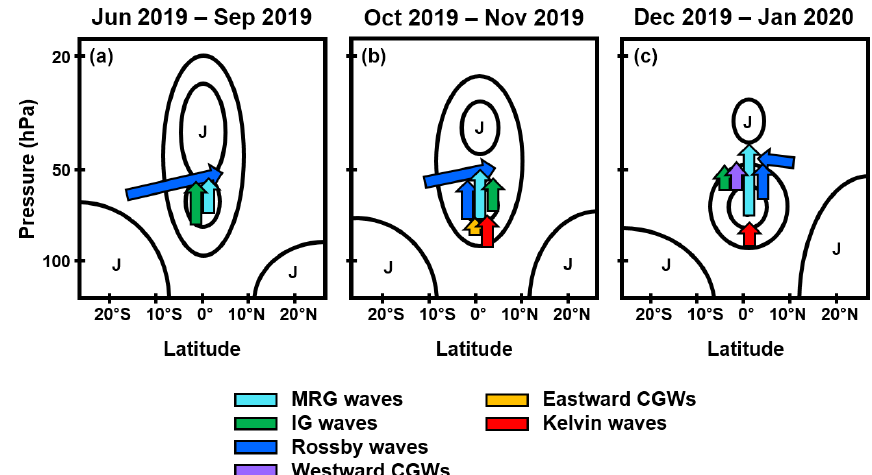
Figure 14. Schematic of the zonal-mean zonal wind (black contour) and the wave forcing anomaly compared to the climatology (arrow) during the 2019/20 QBO disruption in June 2019–September 2019 (a) , October 2019–November 2019 (b) , and December 2019–January 2020 (c) . “J” denotes a westerly